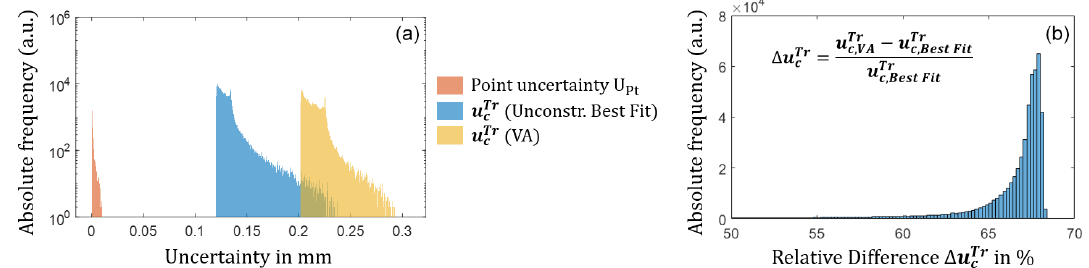
Figure 6. Histogram of the initial uncertainty U Pt and propagated uncertainty u Tr c for VA and the unconstrained (unconstr.) Gaussian best fit (a) . Histogram of relative differences (cid:49)u Tr c between VA and unconstrained Gaussian best fit (b)